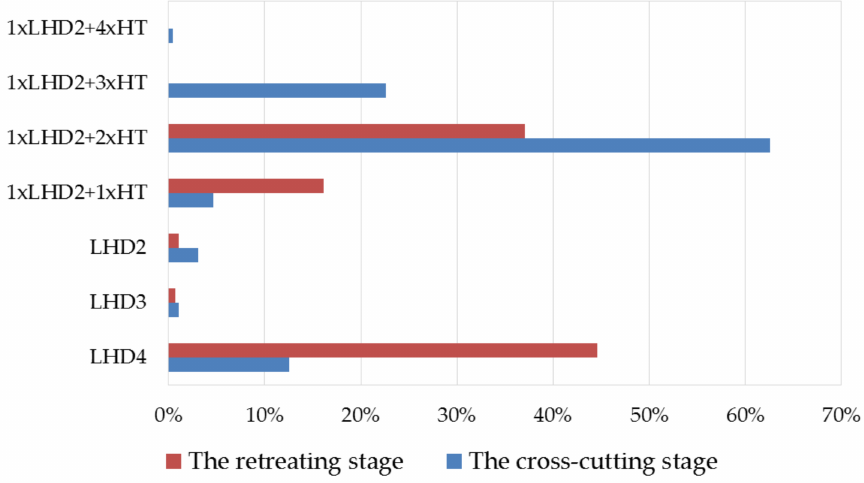
Figure 9. Selection of the means of transport for the winning, depending on the stage of exploitation of the mining